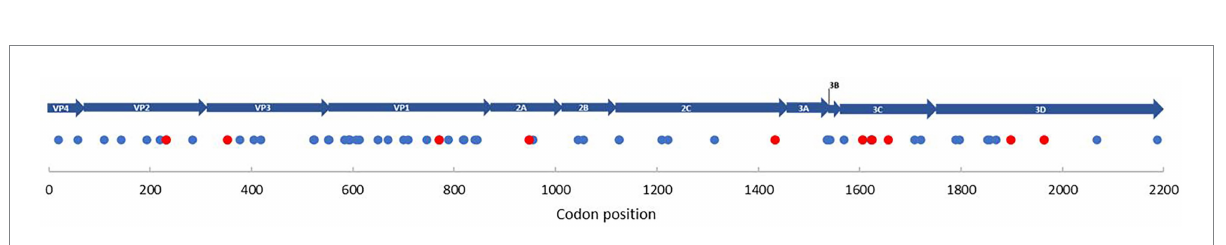
FIGURE 4 Selection pressure on individual codon sites. Blue dots represent the selection pressure on individual codon sites for all reference genomes ( n = 824), along with EV-D68 patients ( n = 19; 1962–2020). Red dots represent the selection pressure on individual codon sites for only EV-D68 patients ( n = 19). MEME was used to determine diversifying selection (PP value < 0.05). Individual sites are specifically indicated in Supplementary Figure S10.